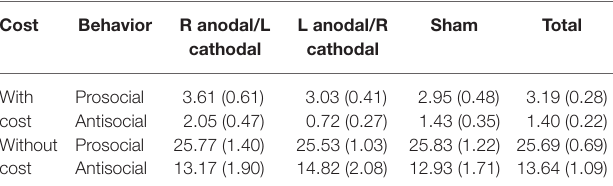
TABLE 1 | Means and SE of the data for prosocial and antisocial behavior with and without cost. Cost